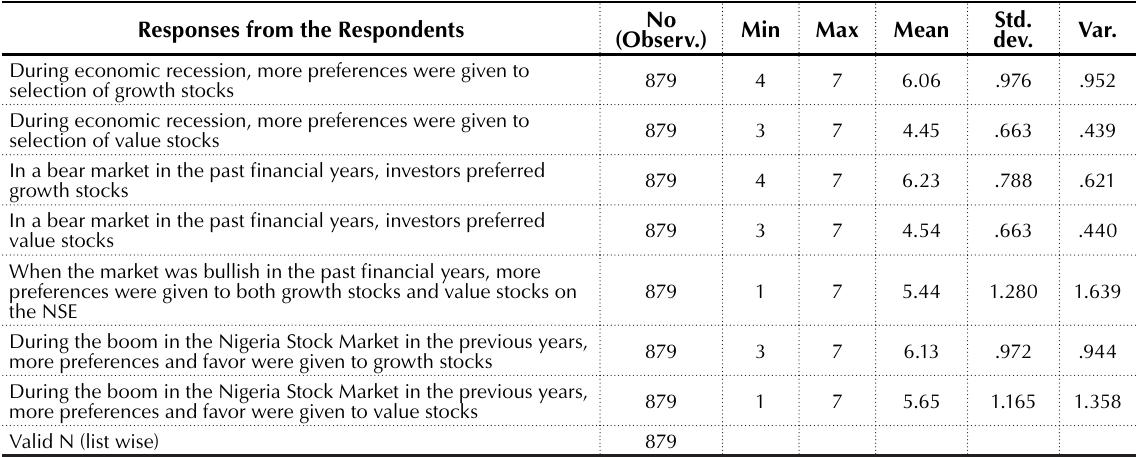
Table 2C. Goodness-of-Fit